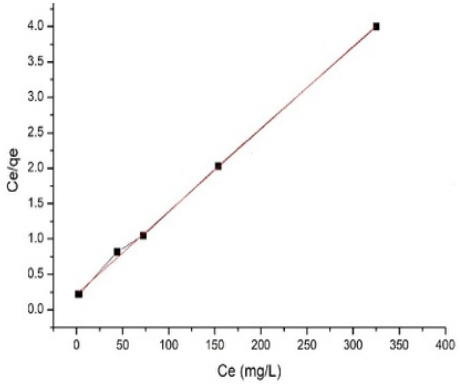
Figure 5. Langmuir isothermal adsorption curve.